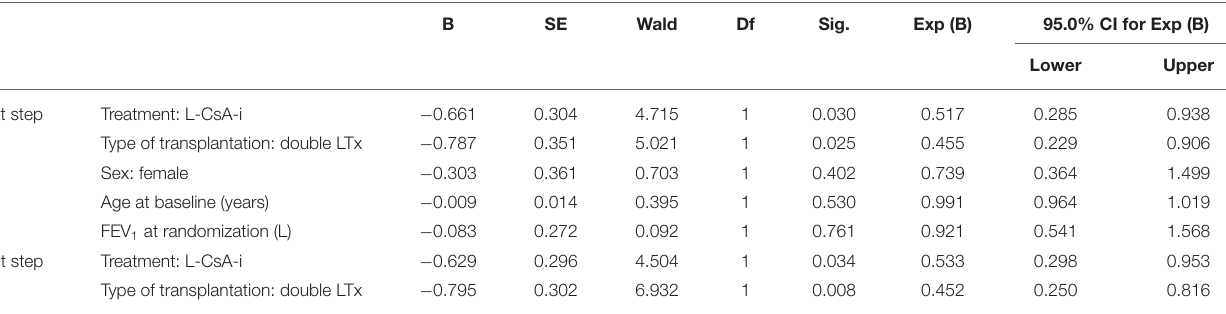
TABLE 3 | Cox regression model with progression to FEV1 baseline % ≥ 20% or below as the dependent variable and parameter estimates for covariates in the